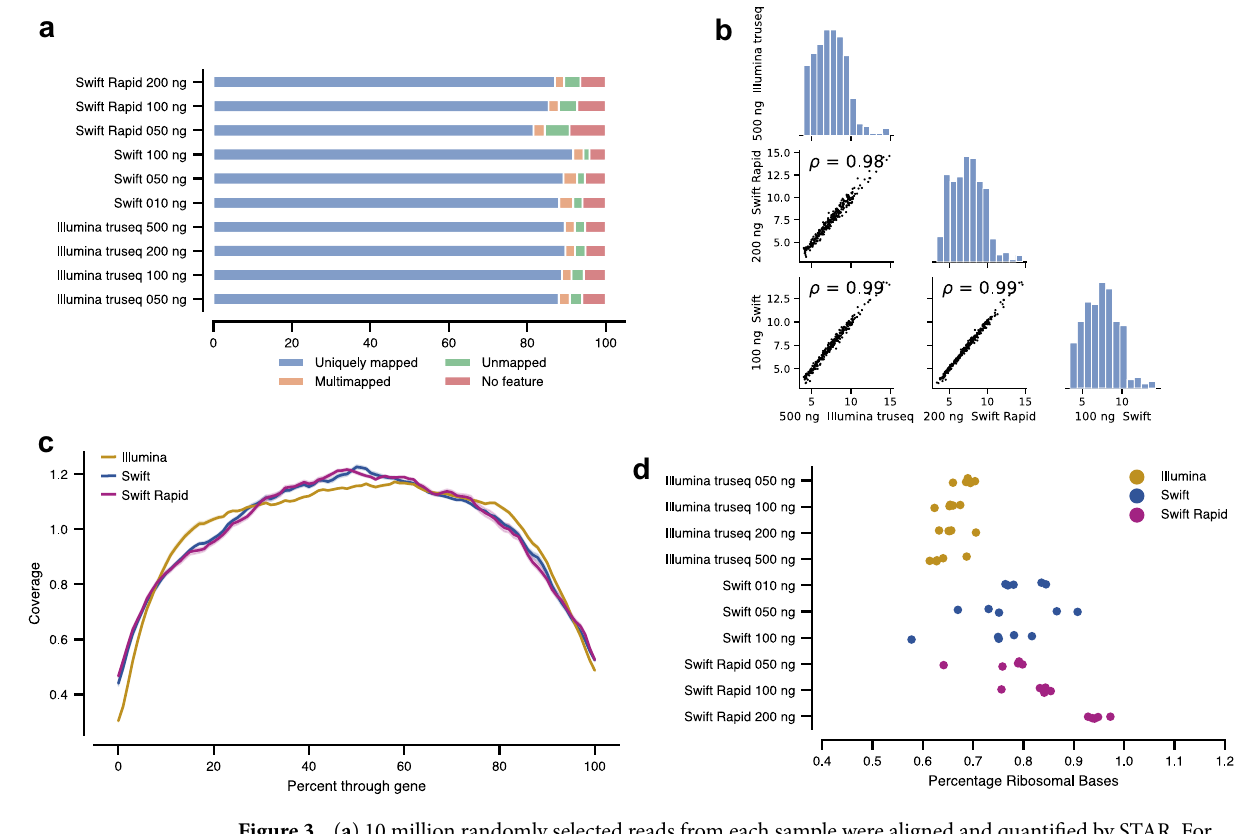
Figure 3. ( a ) 10 million randomly selected reads from each sample were aligned and quantified by STAR. For each library preparation method and input amount, > 80% of reads mapped uniquely to a single gene (average over samples). ( b ) Normalized read counts from identical samples prepared using three methods (Illumina TruSeq with 500 ng input, Swift RNA with 100 ng input, and Swift Rapid RNA with 200 ng input) are highly correlated. ( c ) Read coverage through genes is consistent across all methods (lines shown are averages of samples for each library preparation method). ( d ) The fraction of reads that map to ribosomal genes is less than 1% for all samples.